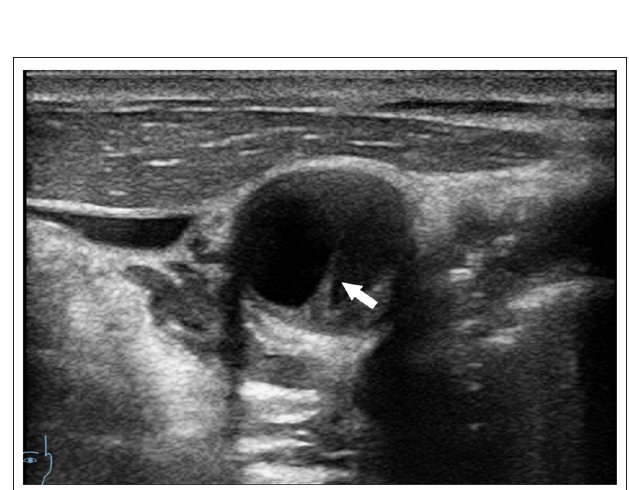
FIGURE 1 | Performance of CaW at the right internal carotid artery of the patient during DSA. Comparied with (A) early-arterial phase, (B) mid-arterial phase, and (C) late-arterial phase showed significant contrast agent retention.